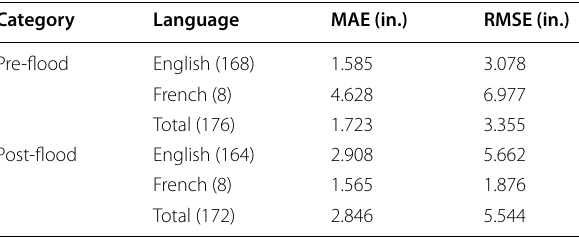
Table 6 The performance of the flood depth estimation